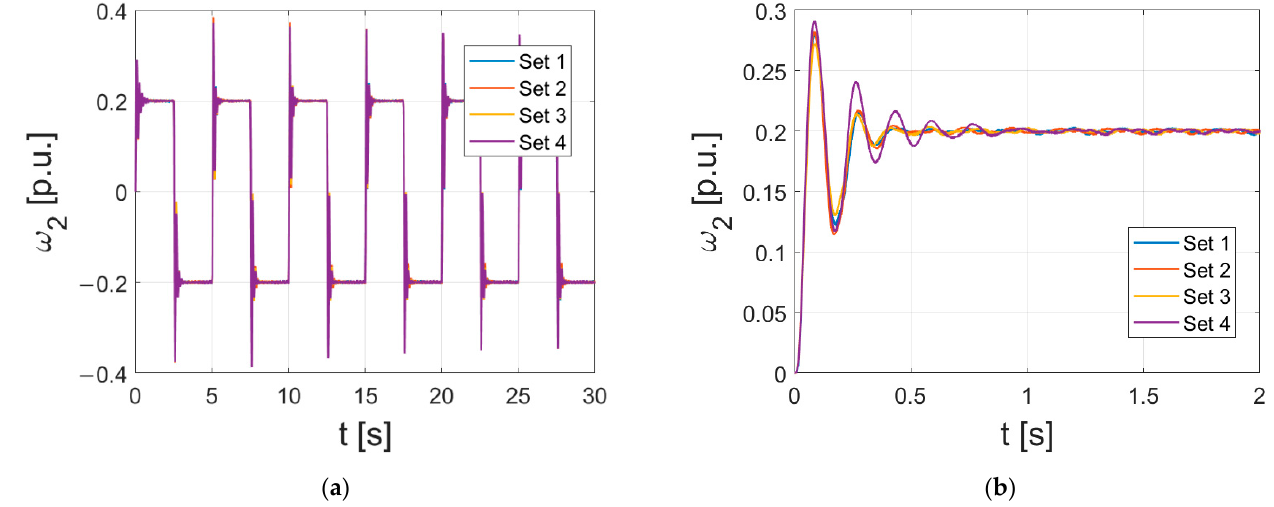
Figure 12. The impact of the initial values of the RBFNN’s weights: ( a ) a general overview of the experimental run; ( b ) a zoom-in at the initial stage of the experimental run.